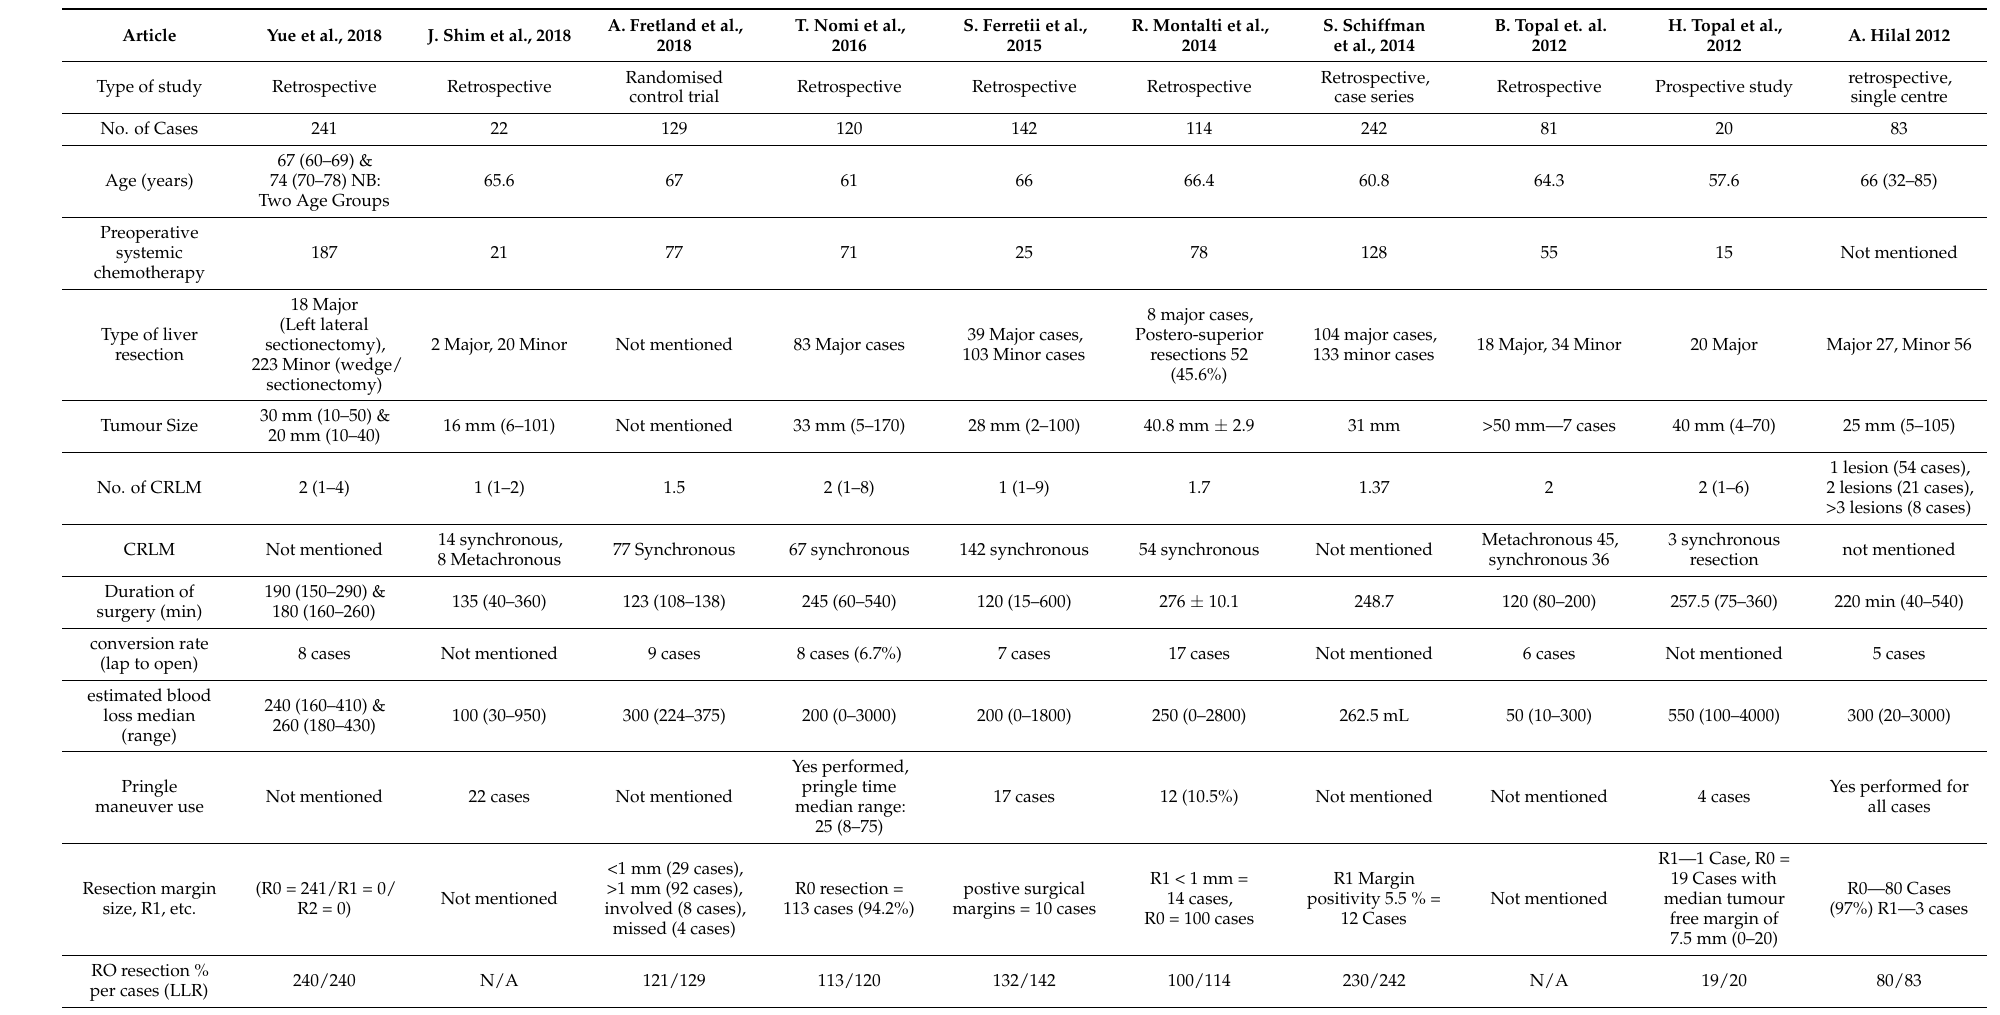
Table 1. Outcomes of the Laparoscopic Liver Resections for